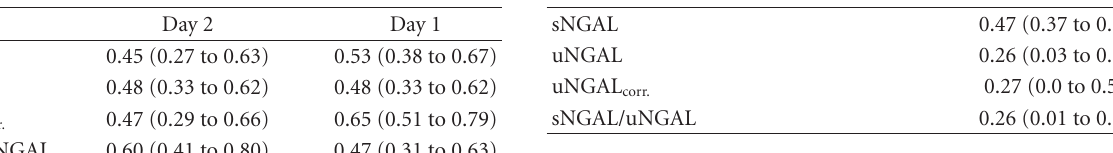
Table 4: AUC (CI) for sNGAL, uNGAL, and uNGAL corr. in pre- dicting